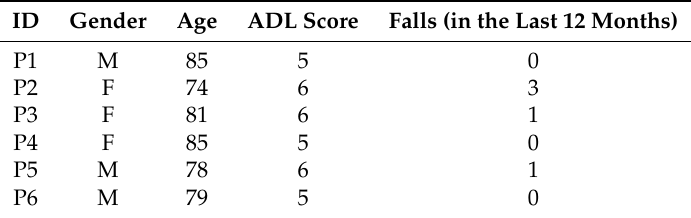
Table 1. Details on the participants involved in the experiment.